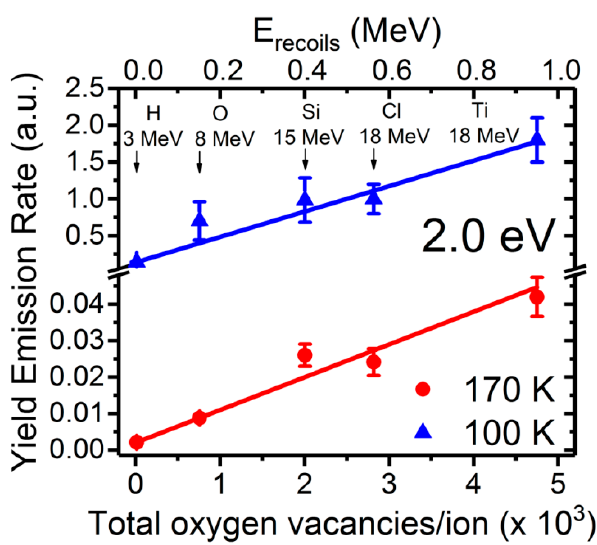
Figure 7. Normalized initial rate of the 2.0 eV emission yield as a function of the total number of oxygen vacancies generated per incident ion [63,64] under irradiation with several ions and energies indicated on the plot. The data correspond to irradiations at 170 K and 100 K. The good fitting evidences a clear linear correlation between the two magnitudes for all the ions at both temperatures. This figure has been reprinted from Crespillo et al. [9], Copyright (2018), with permission from Elsevier.